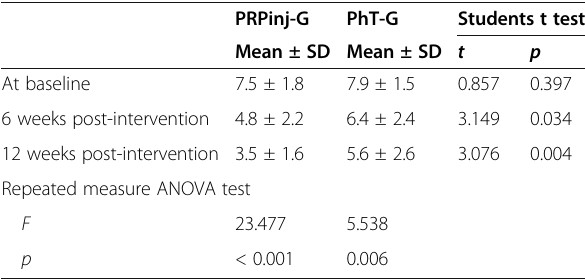
Table 2 Comparison of the VAS-pain score between the PRPinj- G and PhT-G at baseline and after 6 and 12 weeks post- intervention PRPinj-G PhT-G